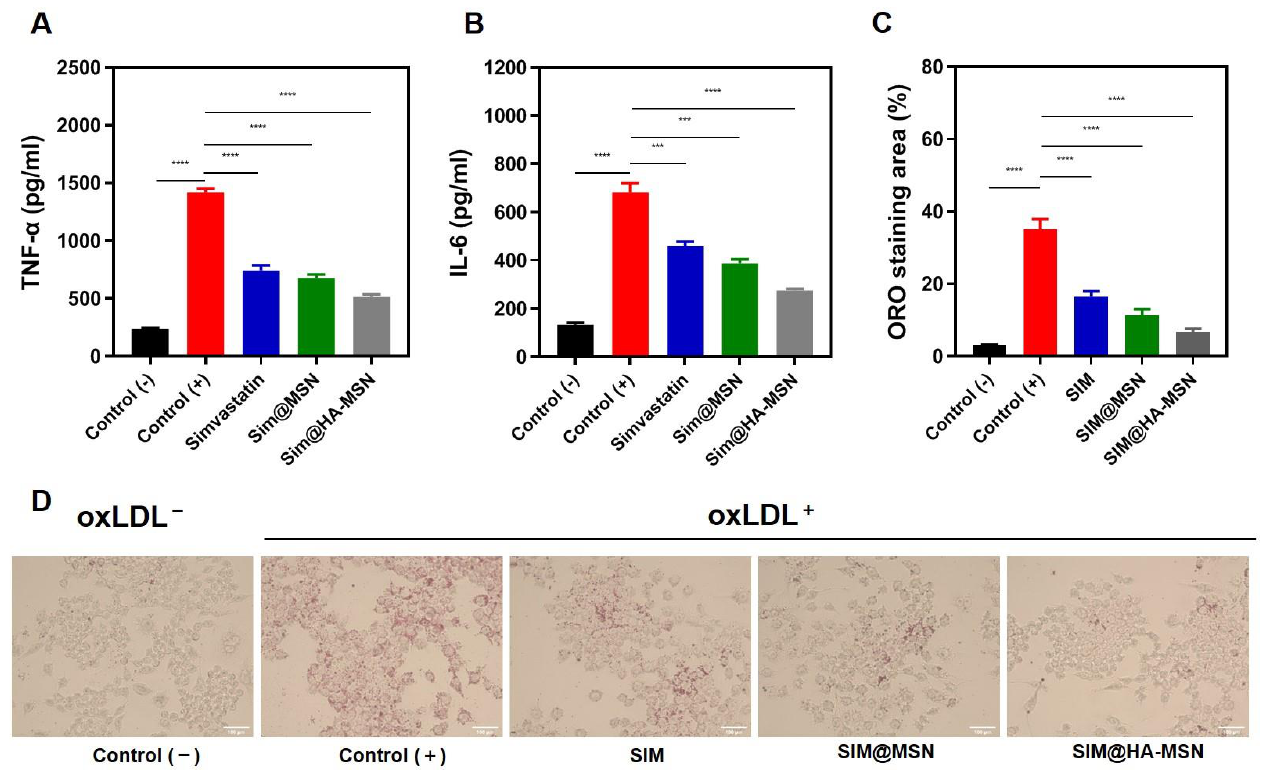
Figure 6. Quantification of proinflammatory cytokines ( A ) TNF- α and ( B ) IL-6 secreted by Raw264.7 cells after different treatments at equivalent SIM concentrations for 24 h ( n = 3). ( C ) Quantification of oil red O staining areas and ( D ) oil red O staining optical microscopy images of Ox-LDL-induced foam cell formation after various treatments at equivalent SIM concentrations for 24 h ( n = 3). Variance among groups was determined by one-way ANOVA with Tukey post-hoc test (*** p < 0.001, **** p < 0.0001).